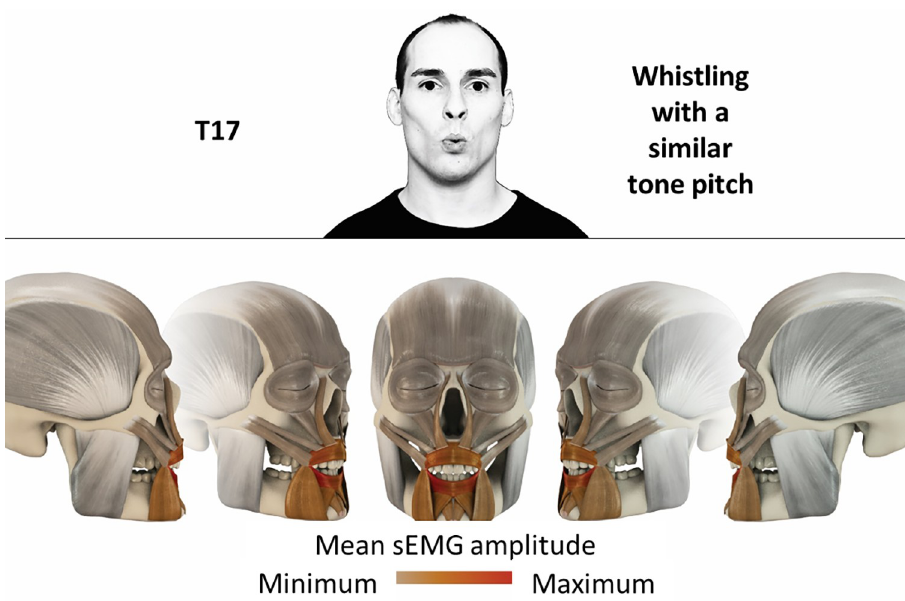
Fig 18. Color-coded facial muscle activation pattern of task T17. Whistling with a similar tone pitch. Animation by Jonas Laustro¨er.